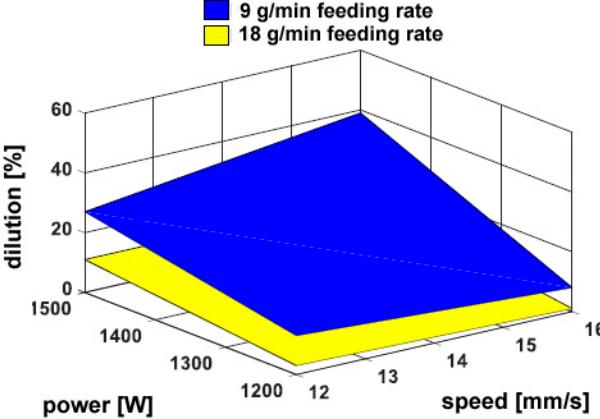
Figure 8. Dilution as a function of the governing variables; flat deposition.